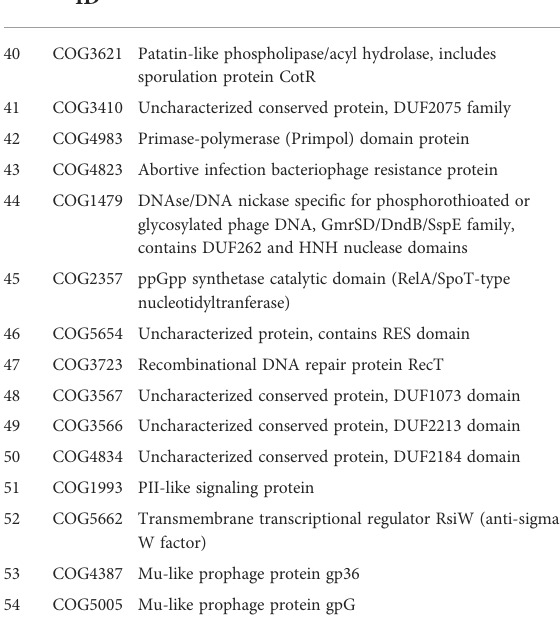
TABLE 1 COG identi fi ed in P. aeruginosa PA_HN002 but not in PAO1.